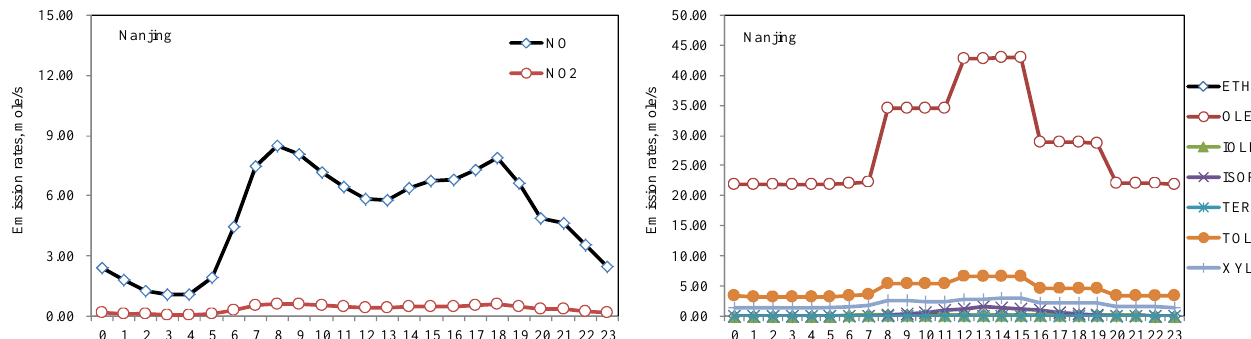
Fig. 13. Emission inputs of NO x and main VOC species at Nanjing Fig.13. Emission inputs of NO